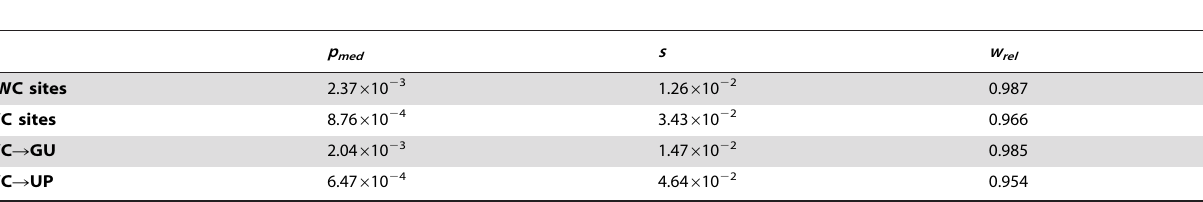
Table 2. Median frequencies, selection coefficients, and relative fitnesses of nWC and single-site WC replacement polymorphisms in the HIV-1 genome.